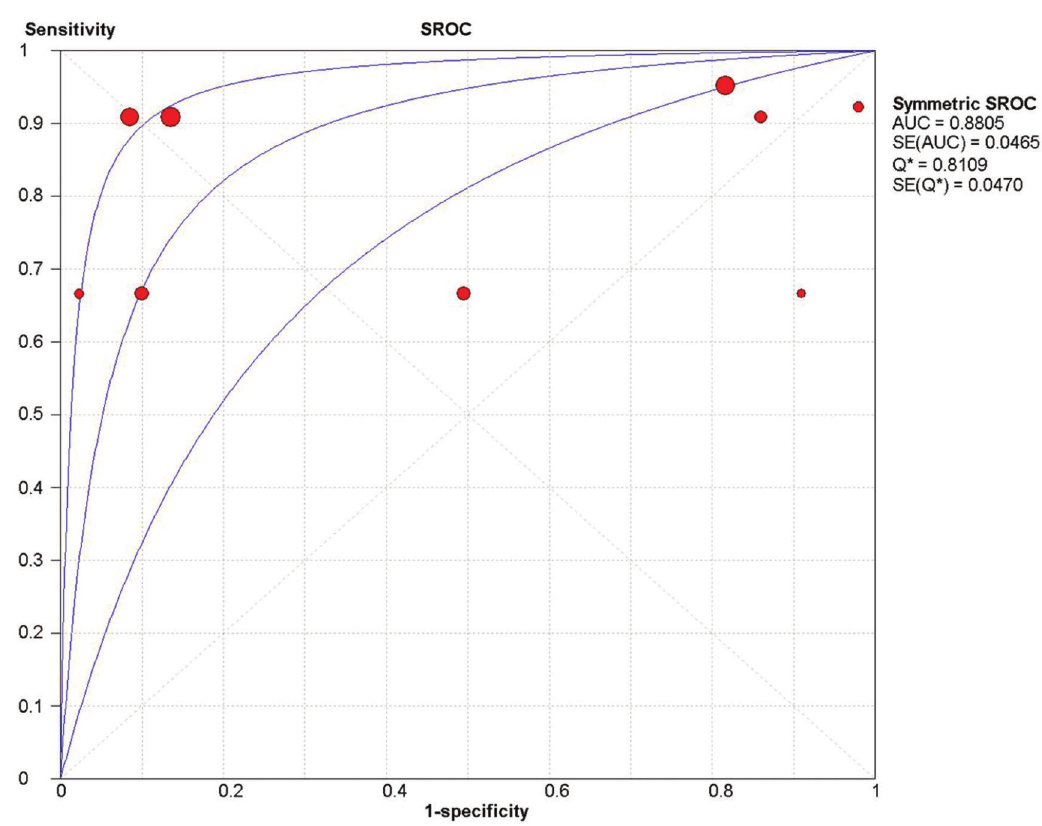
Figure 3 - Threshold effect in covariate analysis of sensitivity and specificity of ICG NIR fluorescence imaging among the studies. AUC, area under the curve; ICG, indocyanine green; NIR, near-infrared; SE, standard error; SROC, summary receiver operating characteristic